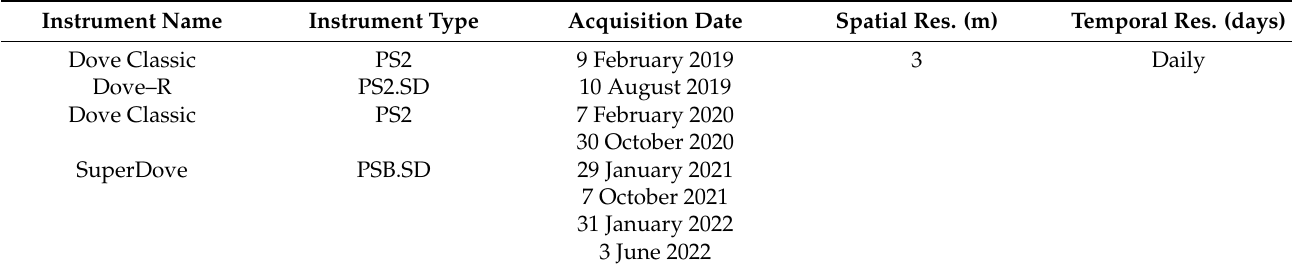
Table 2. Main specification of PS imagery used in the